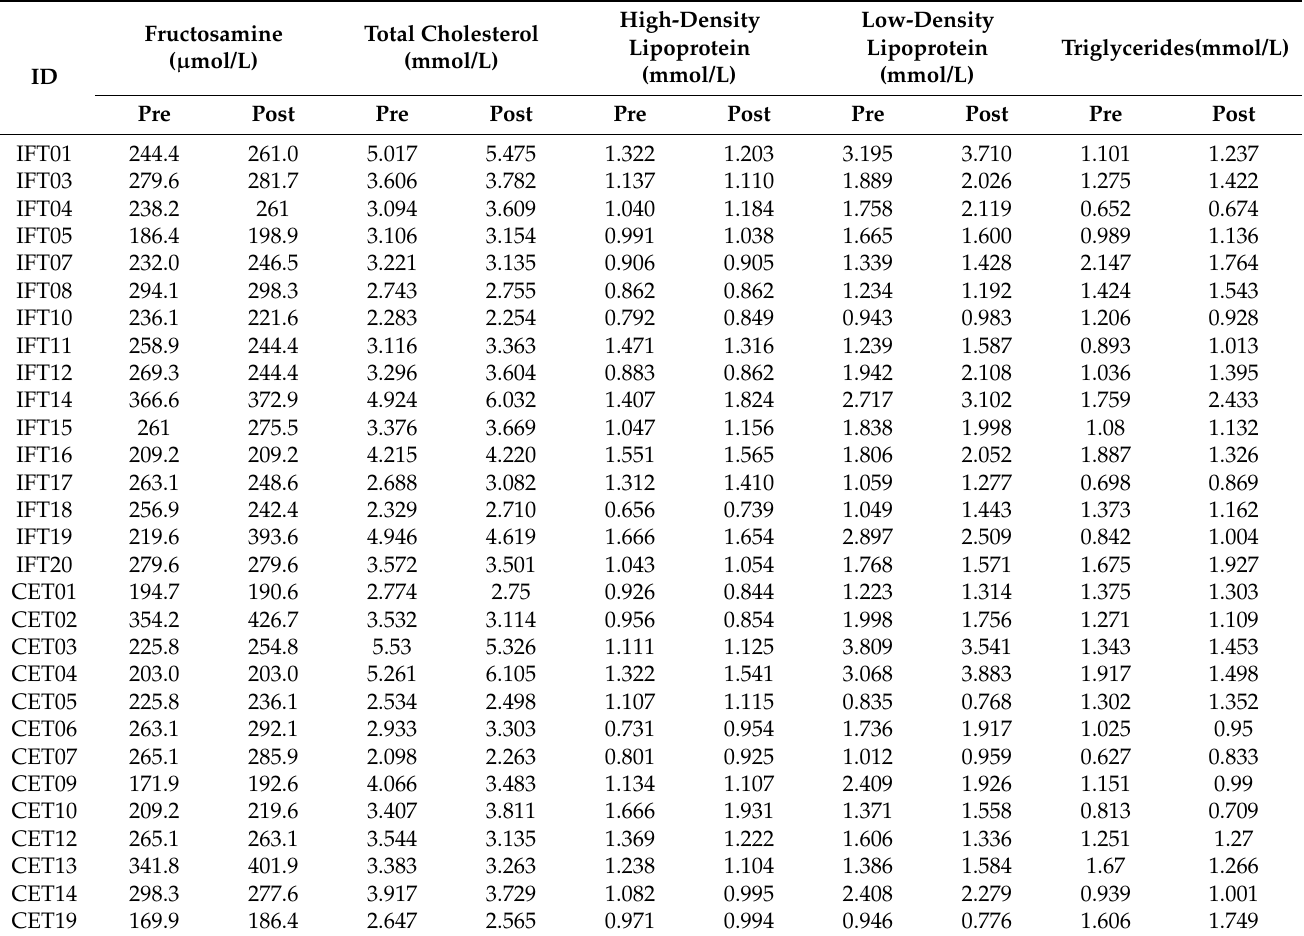
Table 3. Pre to Post Changes in short-term glycemia and lipid profiles during intermittent functional training and constant workload ergometer exercise.